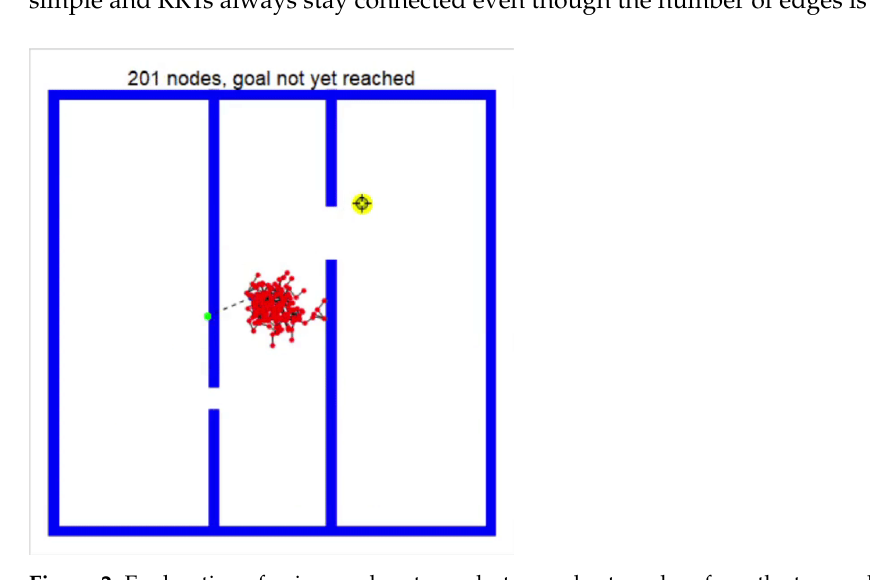
Figure 2. Exploration of naive random tree selects a node at random from the tree and adds an edge in a random direction [58].